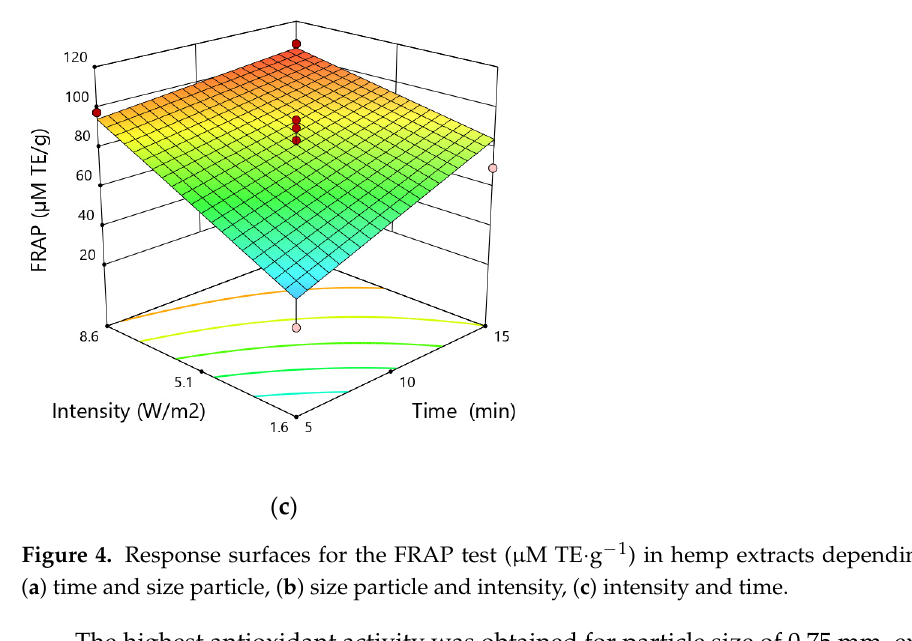
Table 3. ANOVA results for response: FRAP test .